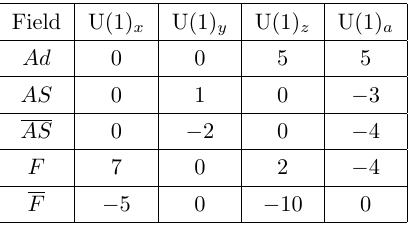
Table 33 . Matter content and assigned charges for an SU(6) gauge